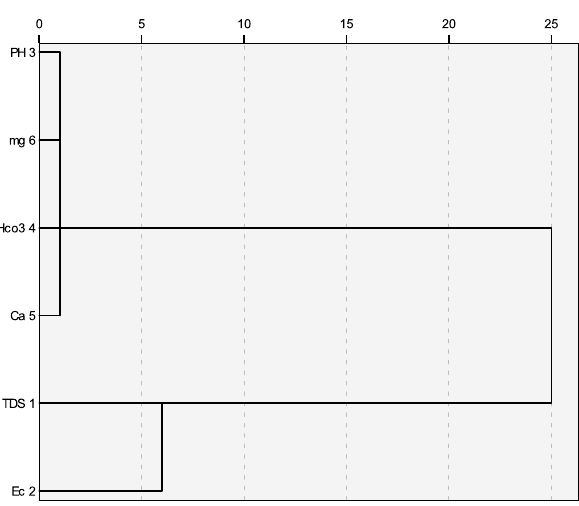
Table 7 Proximity matrix